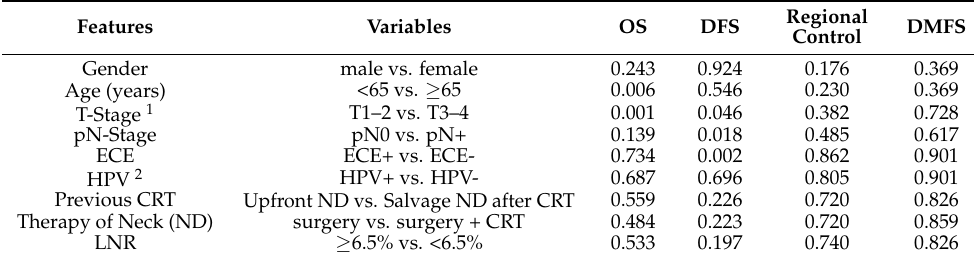
Table A2. Univariate analysis of selective I–III neck dissection * factors associated with survival. N = 73.